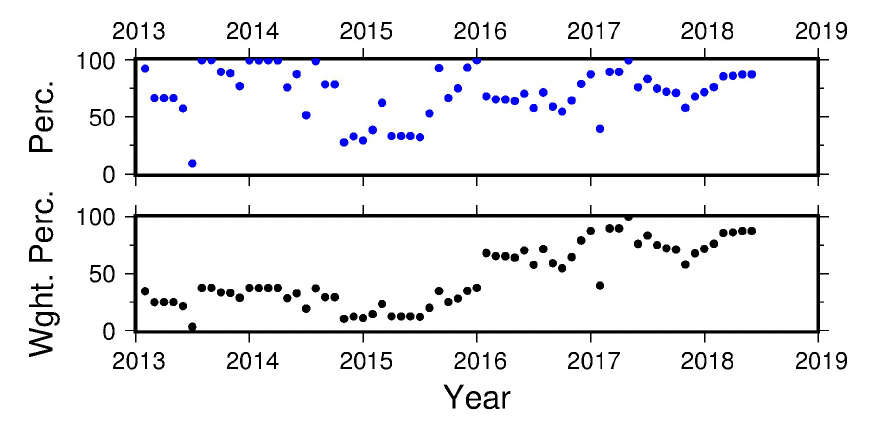
Figure 8. Data availability for the NA network, expressed as percentage (blue) and as weighted percentage (black) per month since 1 January 2013. The weight is the number of deployed stations in each year compared to the current number (eight) of deployed stations: three stations (SABA, SEUS, SMRT) from 2013 to 2016, and five additional stations (SABQ, SABV, SABW, SEUG, SEUT) from 2016